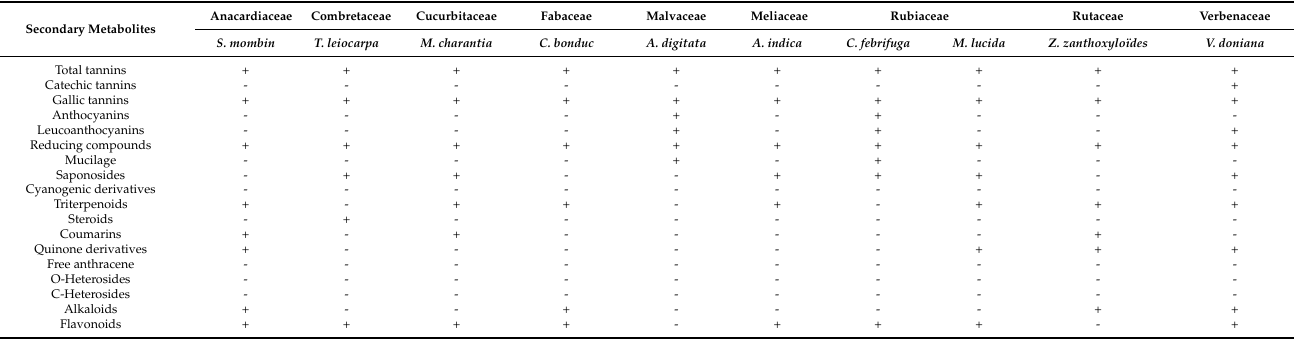
Table 2. Phytochemical screening of the selected plants.